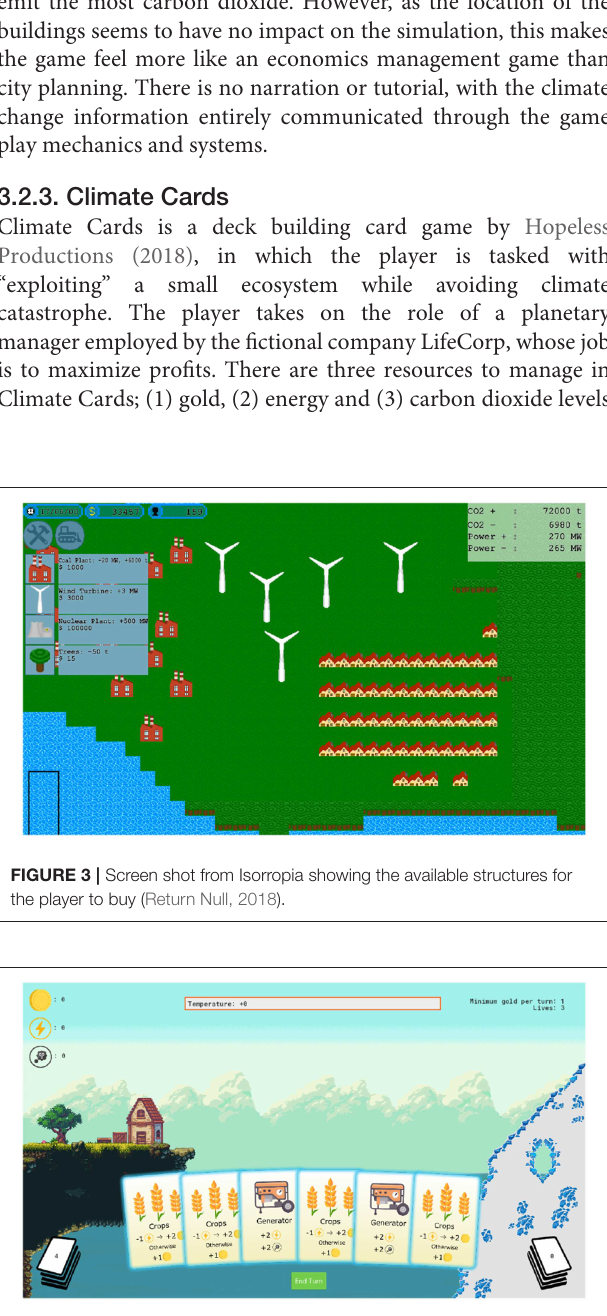
FIGURE 4 | The main game play screen of Climate Card showing the player their hand of cards Hopeless Productions